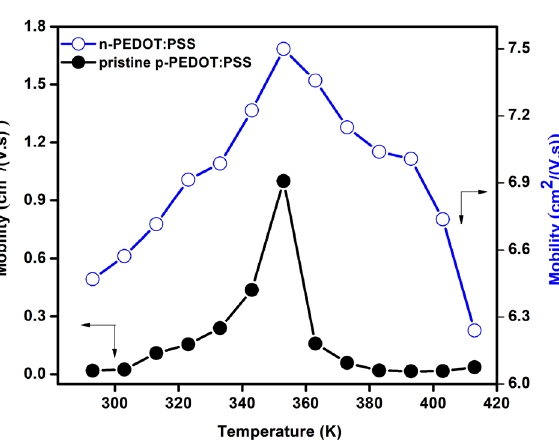
Figure 3. Temperature dependence of the mobility of pristine p-PEDOT:PSS and n-PEDOT:PSS